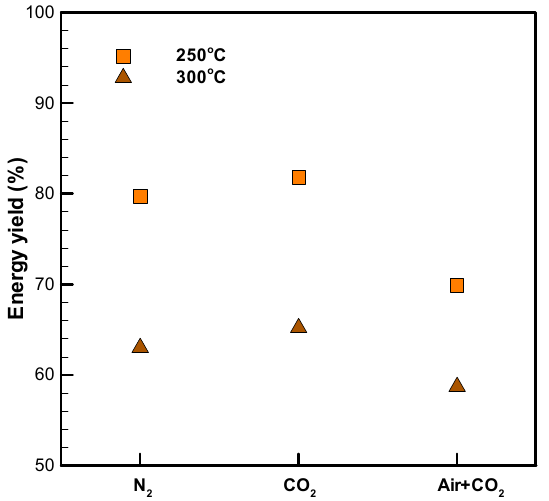
Figure 7. Profiles of energy yield of torrefied corncob